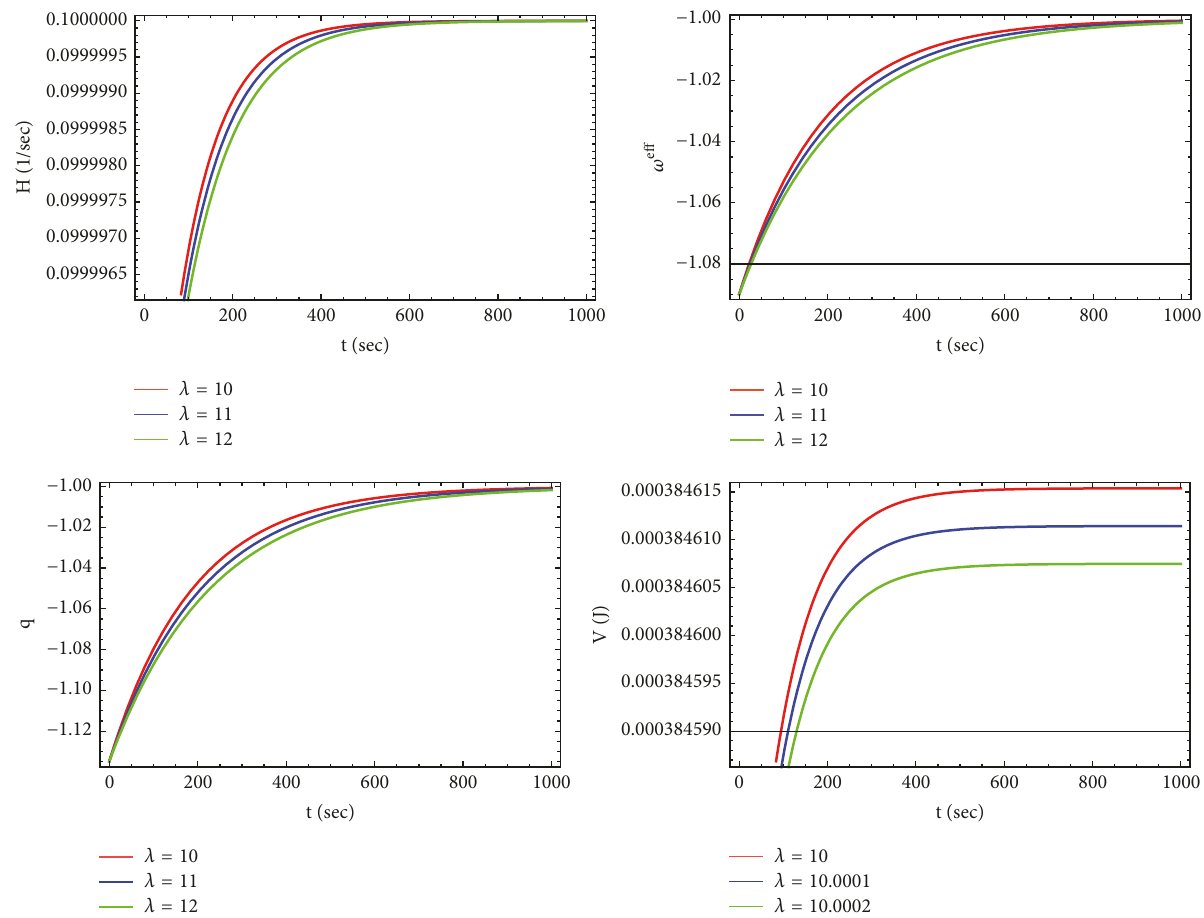
Figure 3: Plots of 𝐻 , 𝜔 𝑒𝑓𝑓 , 𝑞 , and 𝑉 versus 𝑡 for 𝑊(𝜑) = 𝑏 3 sin 𝜑 , 𝑏 3 = 0.1(1/𝑠𝑒𝑐) , and 𝑐 3 = 5 when 𝑘 = 0